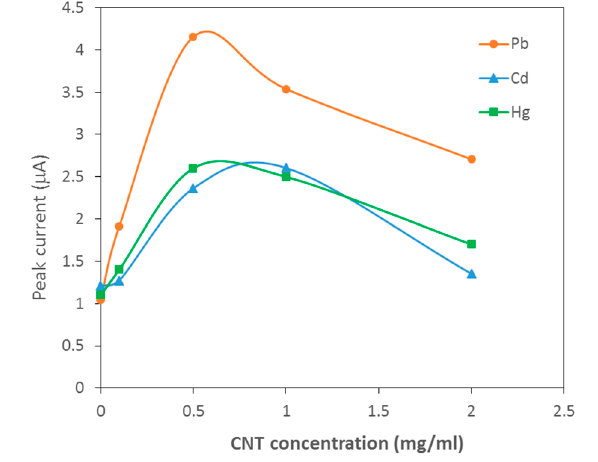
Figure 4. Peak DPSAV current vs. CNT content towards 200 µg/L Pb, 400 µg/L Cd and 400 µg/L Hg.